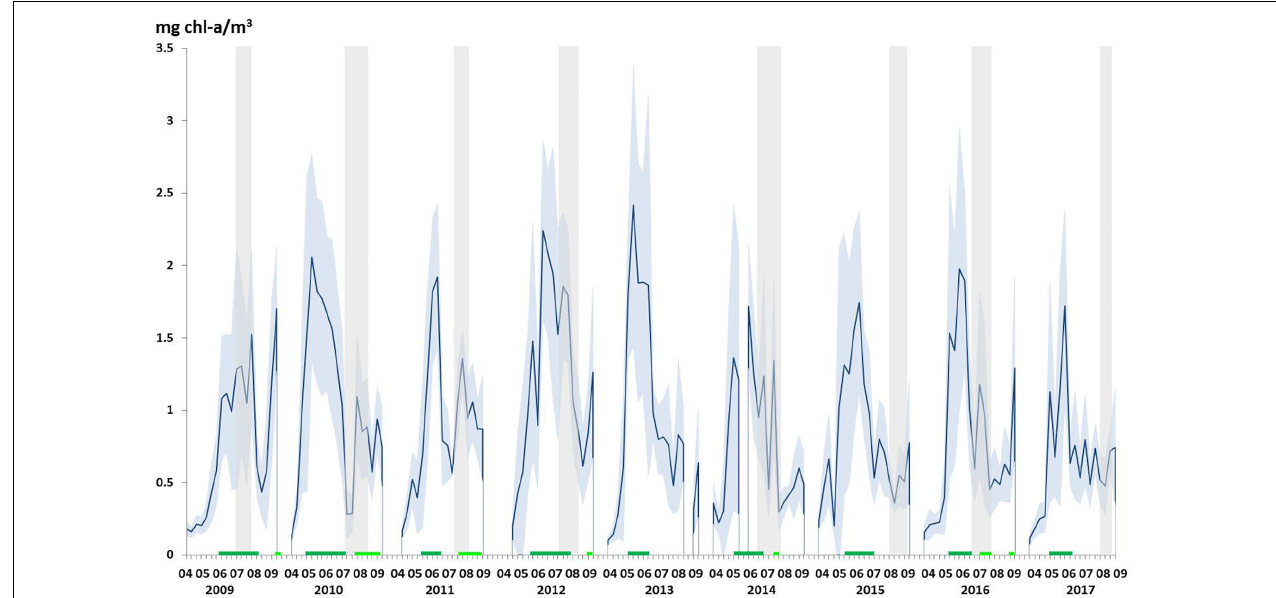
FIGURE 2 | Average (mean) chlorophyll a (Chl- a ) concentrations during the period April–August from 2009 to 2017 as derived from satellite data (the standard deviation is indicated by the shaded area). Periods of the 1st bloom and the 2nd blooming time within a year (mean value above 0.85 mg/m 3 chl-a concentration) are indicated by dark and light green lines, respectively. Periods of campaigns are indicated by gray bars. Chl- a concentration averages are based on 8-days average products within the HAUSGARTEN area (78.42 ◦ N–79.5 ◦ N and 2.27 ◦ E–6.2 ◦